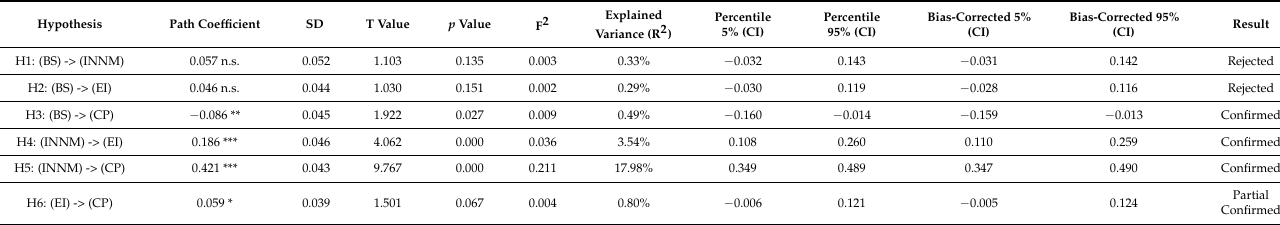
Table 4. Model Hypothesis Test.